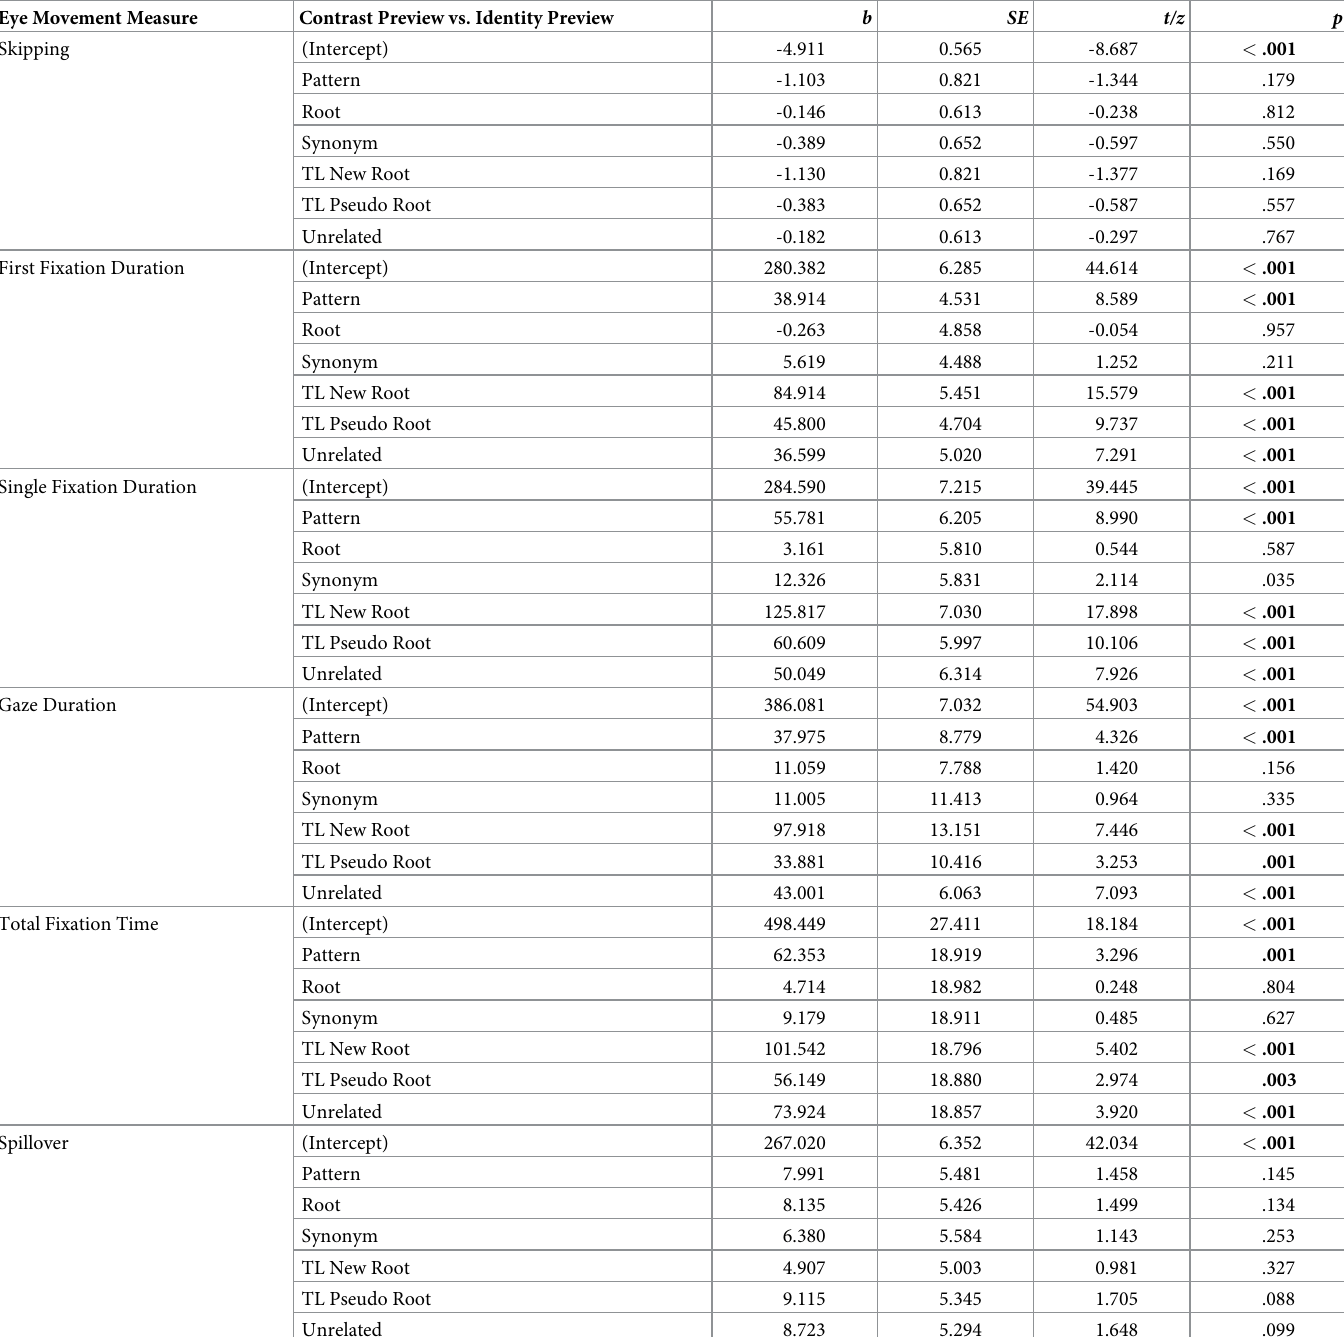
Table 3. Linear mixed models outputs for the contrast matrix of measures with Identity preview as baseline. Eye Movement